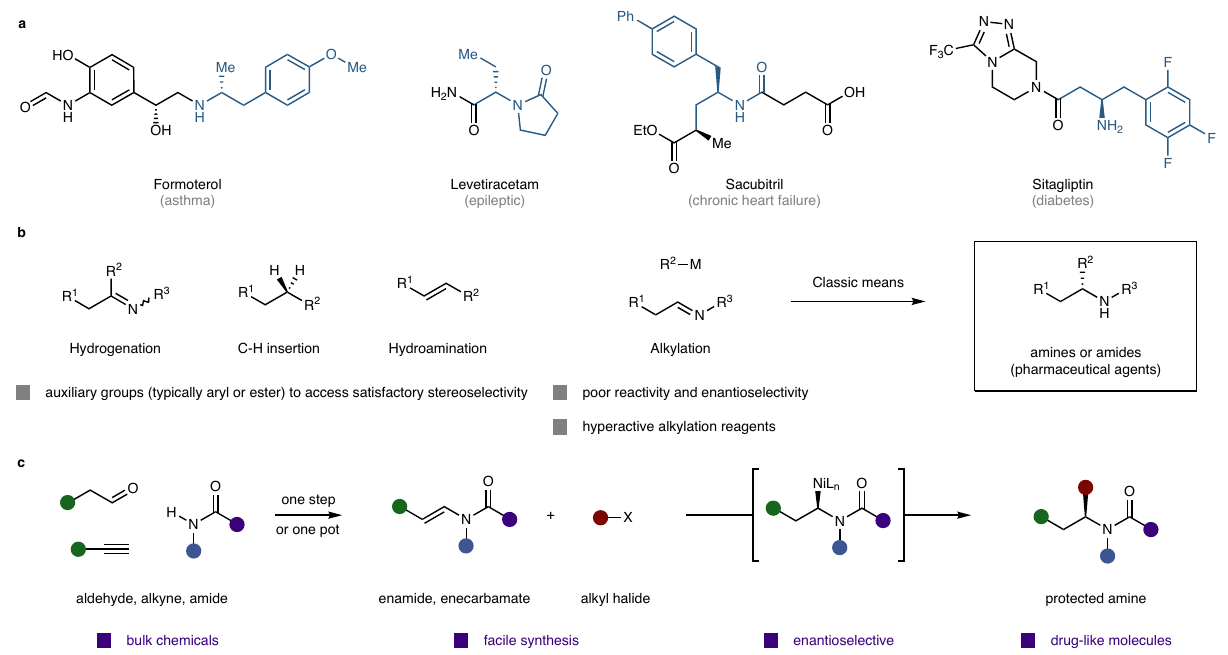
Fig. 1 Design of a modular enamide/enecarbamate reductive hydroalkylation for the synthesis of chiral aliphatic amines. a Representative drug molecules demonstrating the universal existence of chiral aliphatic amines in biologically active molecules. b Catalytic asymmetric reductive hydroalkylation of enamides and enecarbamates enables rapid access to the privileged chiral aliphatic amines, complementing mainstream approaches that are limited by auxiliary groups to access satisfactory stereoselectivity. c Synthetic analysis and proposed mechanism of enamide and enecarbamate reductive hydroalkylation. Enamides and enecarbamates are prepared via facile syntheses from bulk chemicals — aldehydes, alkynes and amides. It was assumed that this reaction involved regio- and stereoselective hydrometallation of an enamide or enecarbamate to generate a catalytic amount of enantioenriched alkylnickel intermediate, followed by C – C bond formation with alkyl electrophile to yield chiral